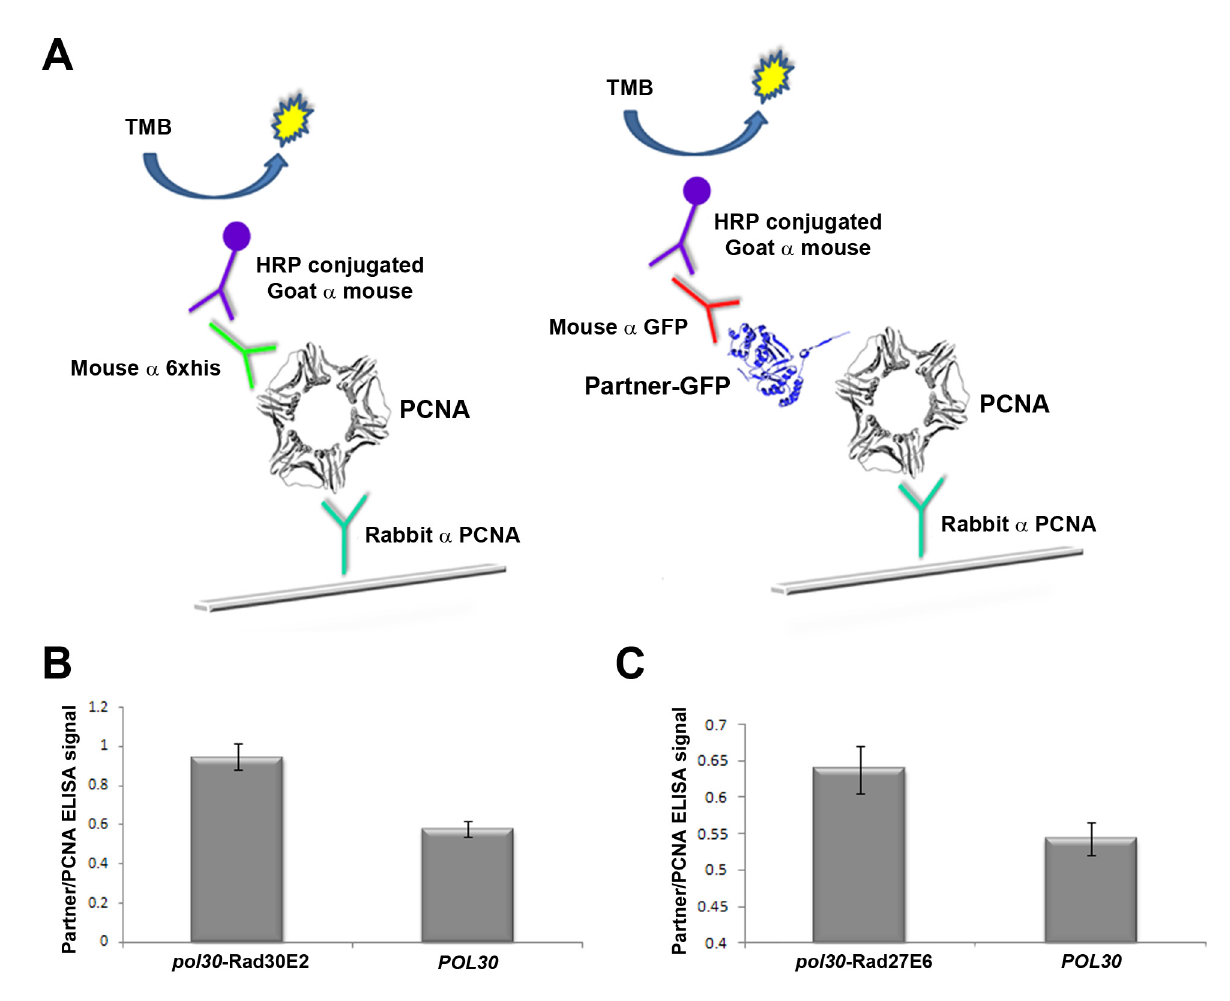
Figure 4. Increased levels of in vivo PCNA-partner complex formation in the pol30 -Rad30E2 or the pol30 -Rad27E6 mutant strains, relative to the POL30 strain. (A). ELISA experimental set-up for the detection of PCNA-partner complexes extracted directly from WT and mutant PCNA strains. The assay is based on the immobilization of PCNA-partner complex using anti-PCNA antibody-coated ELISA plates. Detection of complex levels is performed using antibodies against the GFP fused to the C-terminal of the PCNA partner. The level of extracted complex is normalized to the total levels of PCNA immobilized on the plate using antibodies against a 6 6 histidine tag fused to PCNA. (B,C) The ELISA signal of the PCNA-Rad30 (B) or PCNA-Rad27 (C) complex normalized to the overall immobilized PCNA signal. The increase in complex formation in the pol30 - Rad30E2 (B) and pol30 -Rad27E6 (C) mutant strains, relative to the POL30 WT strain, is 70% and 17% for the PCNA-Rad30 and PCNA-Rad27 complexes,